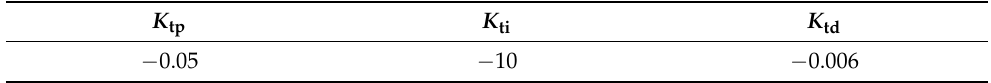
Table 5. Parameters of the traditional PID